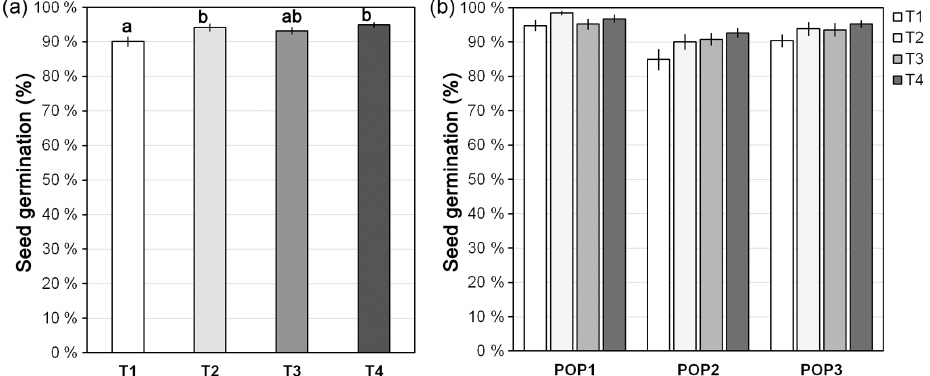
Figure A1. Seed germination (mean ± SE; in %) for (a) different cold treatments and (b) each treatment within each studied population. Treatment before transfer to the growth chamber: T1, without cold treatment; T2, 3 days at 4 ◦ C; T3, 1 week at 4 ◦ C; and T4, 2 weeks at 4 ◦ C. Different lower-case letters denote significant differences among treatments at P < 0 .